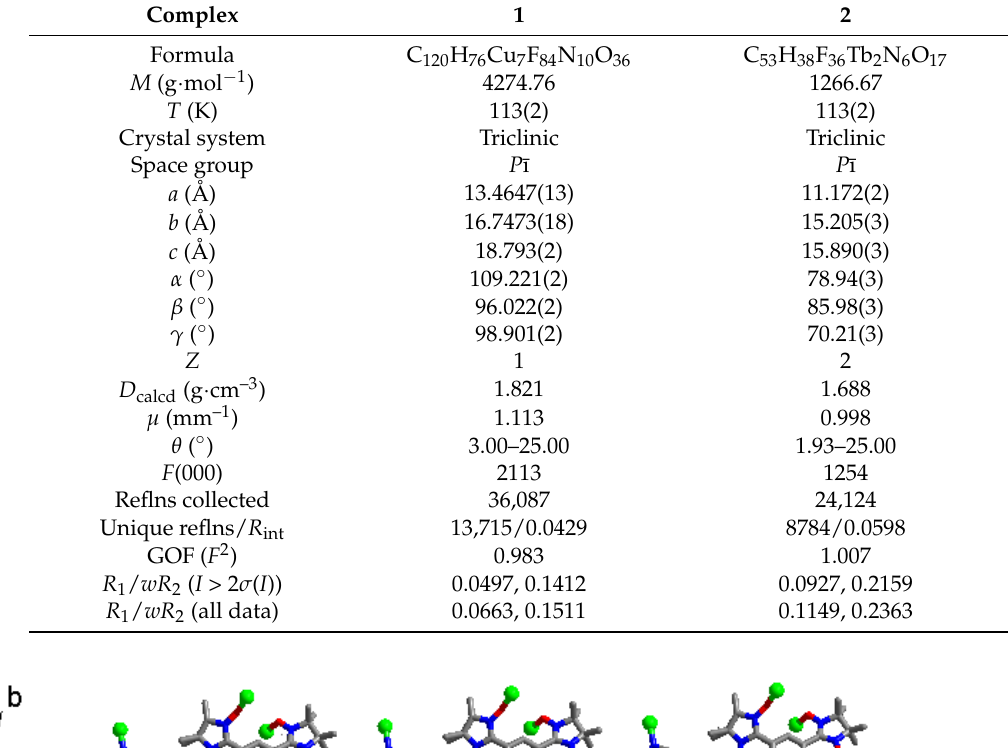
Table 1. Crystallographic structural data of two-dimensional polymers 1 and 2 .